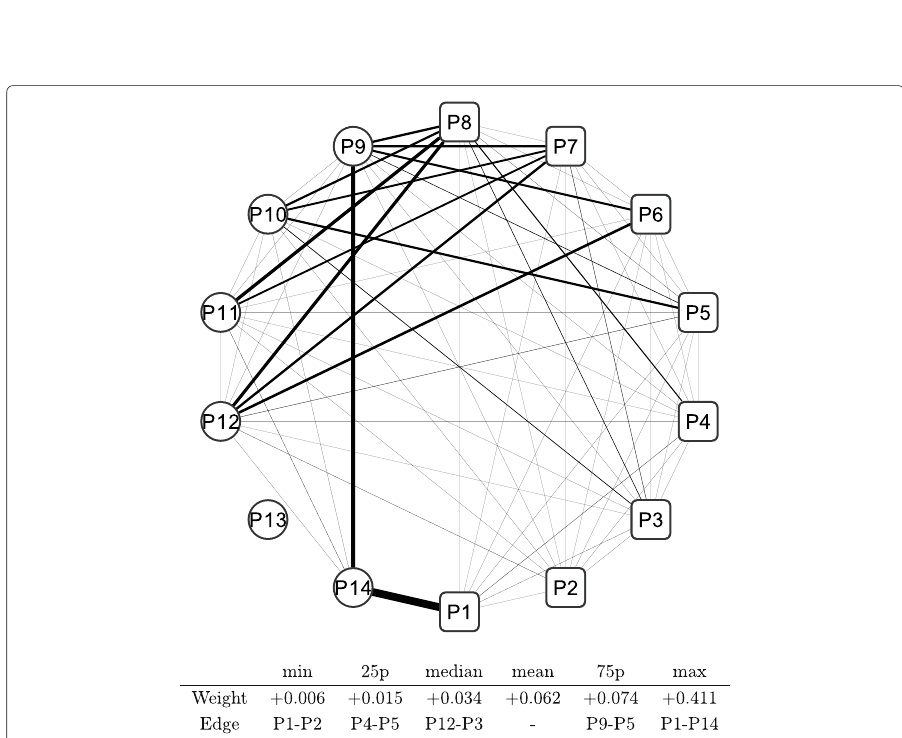
Fig. 15 Changes in network between sub-periods: T3–T2. Note: The network shows the difference between the sub-period T3 and T2. The edge weight (the edge width) is calculated by subtracting elements of the adjacency matrix of T2 from those of T3 described as T3 − T2. Only the edges that have positive weights (T3 > T2) are shown. The bottom table shows the quantiles of edge weights distribution with corresponding